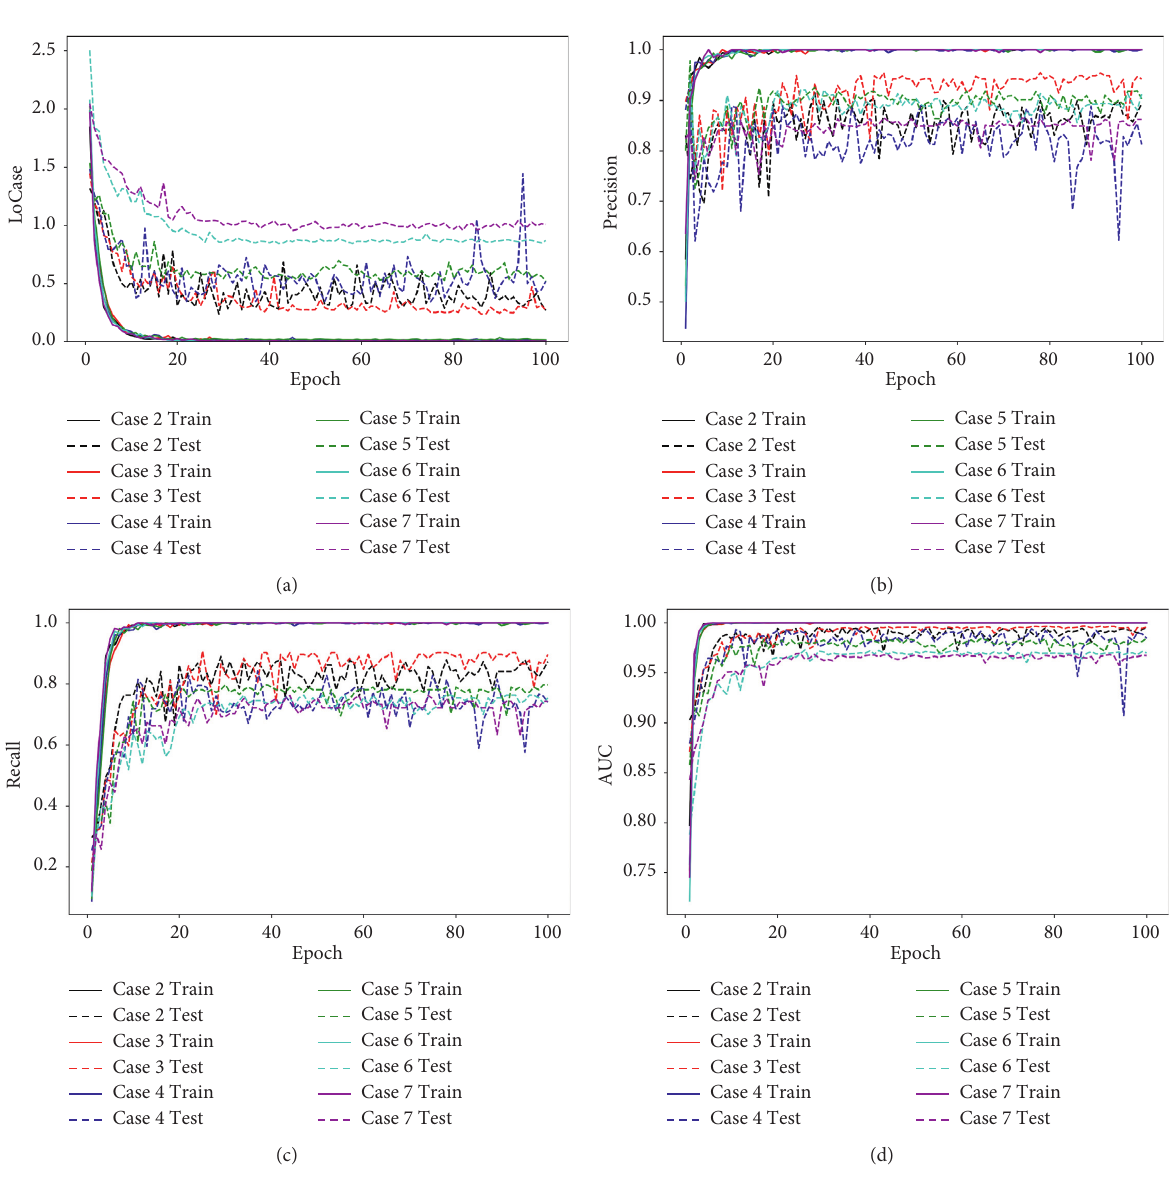
Figure 15: Metrics of GCNN for the ten-classes scenario across different cases. (a) Loss, (b) precision, (c) recall, and (d) AUC.